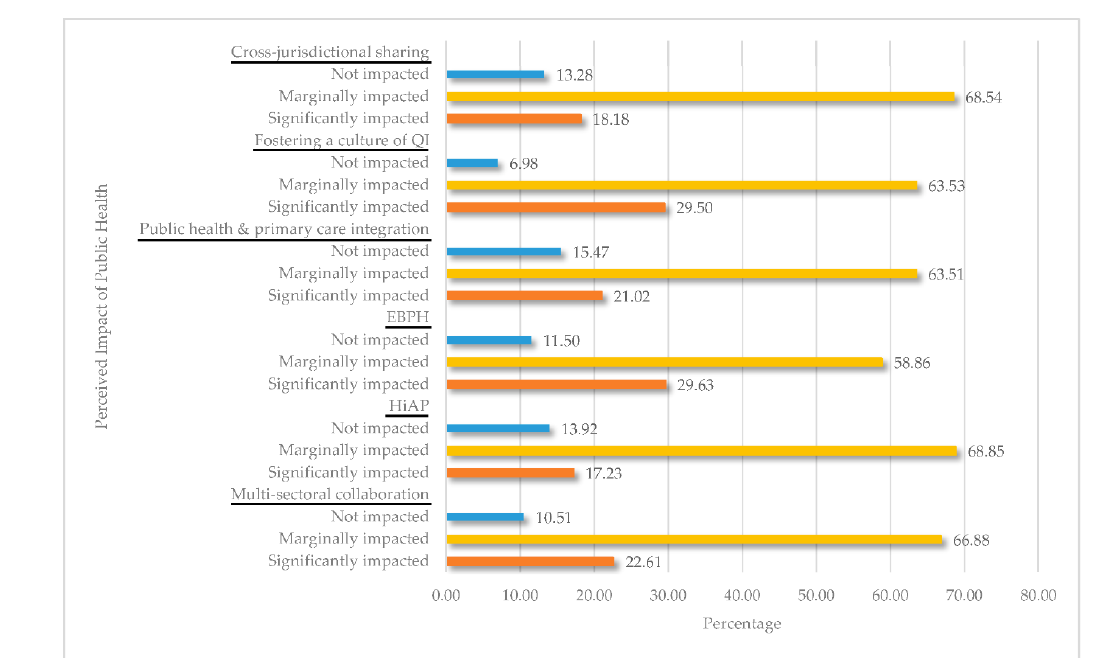
Figure 1. Percent distribution of employees by the perceived impact of the emerging public health issues on the day-to-day work of state and local public health workforce, 2017 Public Health Workforce Interests and Needs Survey (PH WINS). Abbreviations: QI, quality improvement; EBPH, evidence-based public health; HiAP, Health in All